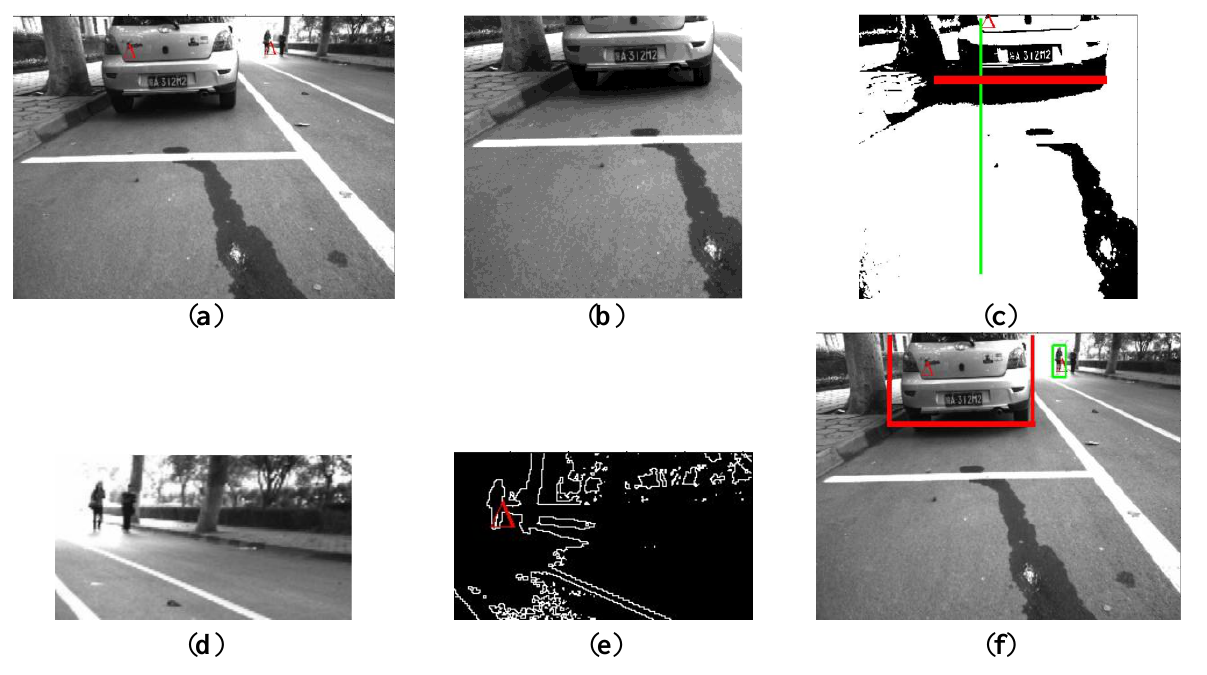
Figure 12. Detection of obstacle boundaries: ( a ) radar-vision point alignment ( b ) one candidate region ( R1 ) with an obstacle ( c ) shadow detection result in R1 ( d ) another candidate region ( R2 ) with an obstacle ( e ) edge detection result in R2 ( f ) final results of boundary